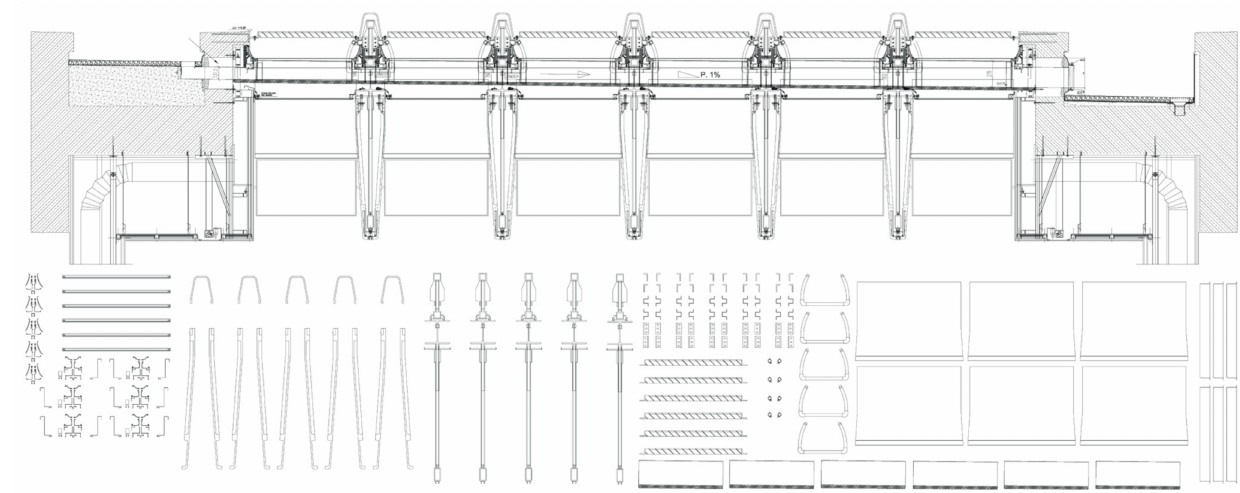
Figure 9. MAXXI, Rome (2010). Top: roof cross-section taken on one of the gutters (courtesy: MAXXI). Bottom: the same section decomposed in the elements assembled onsite (auth. Cardellicchio,